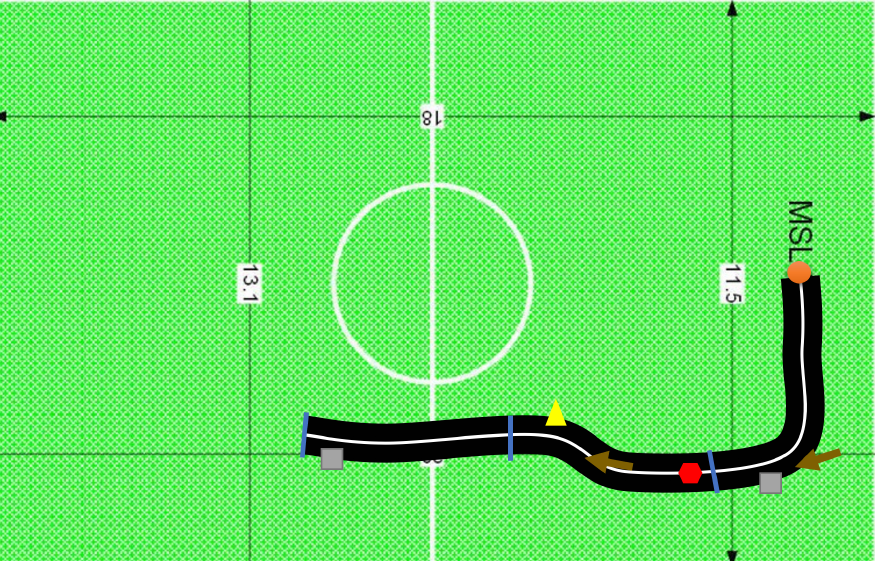
Figure 8. Schematic of the AR environment for the second user study. Description: The orange circle represents the starting position; the blue lines are the passage points; the brown arrows are directional arrow objects; the gray squares are obstacles; the yellow triangle is a spotlight; the red hexagon is a stop